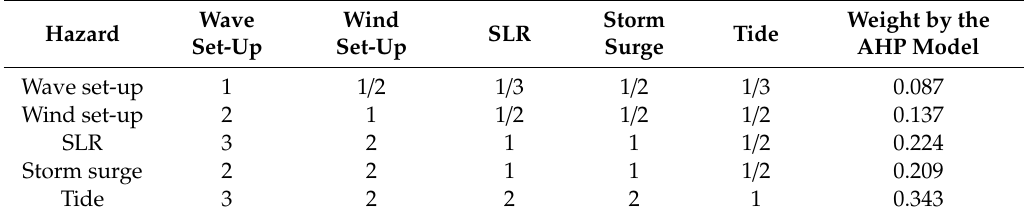
Table 5. Pairwise comparison matrix of flood hazard indicators in Bandar Abbas